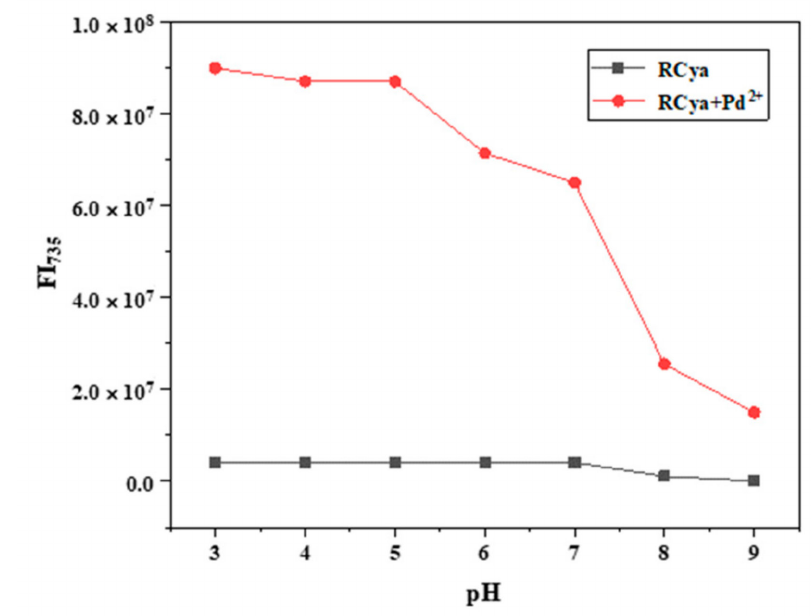
Figure 5. pH dependence of probe RCya in the absence and presence of Pd 2+